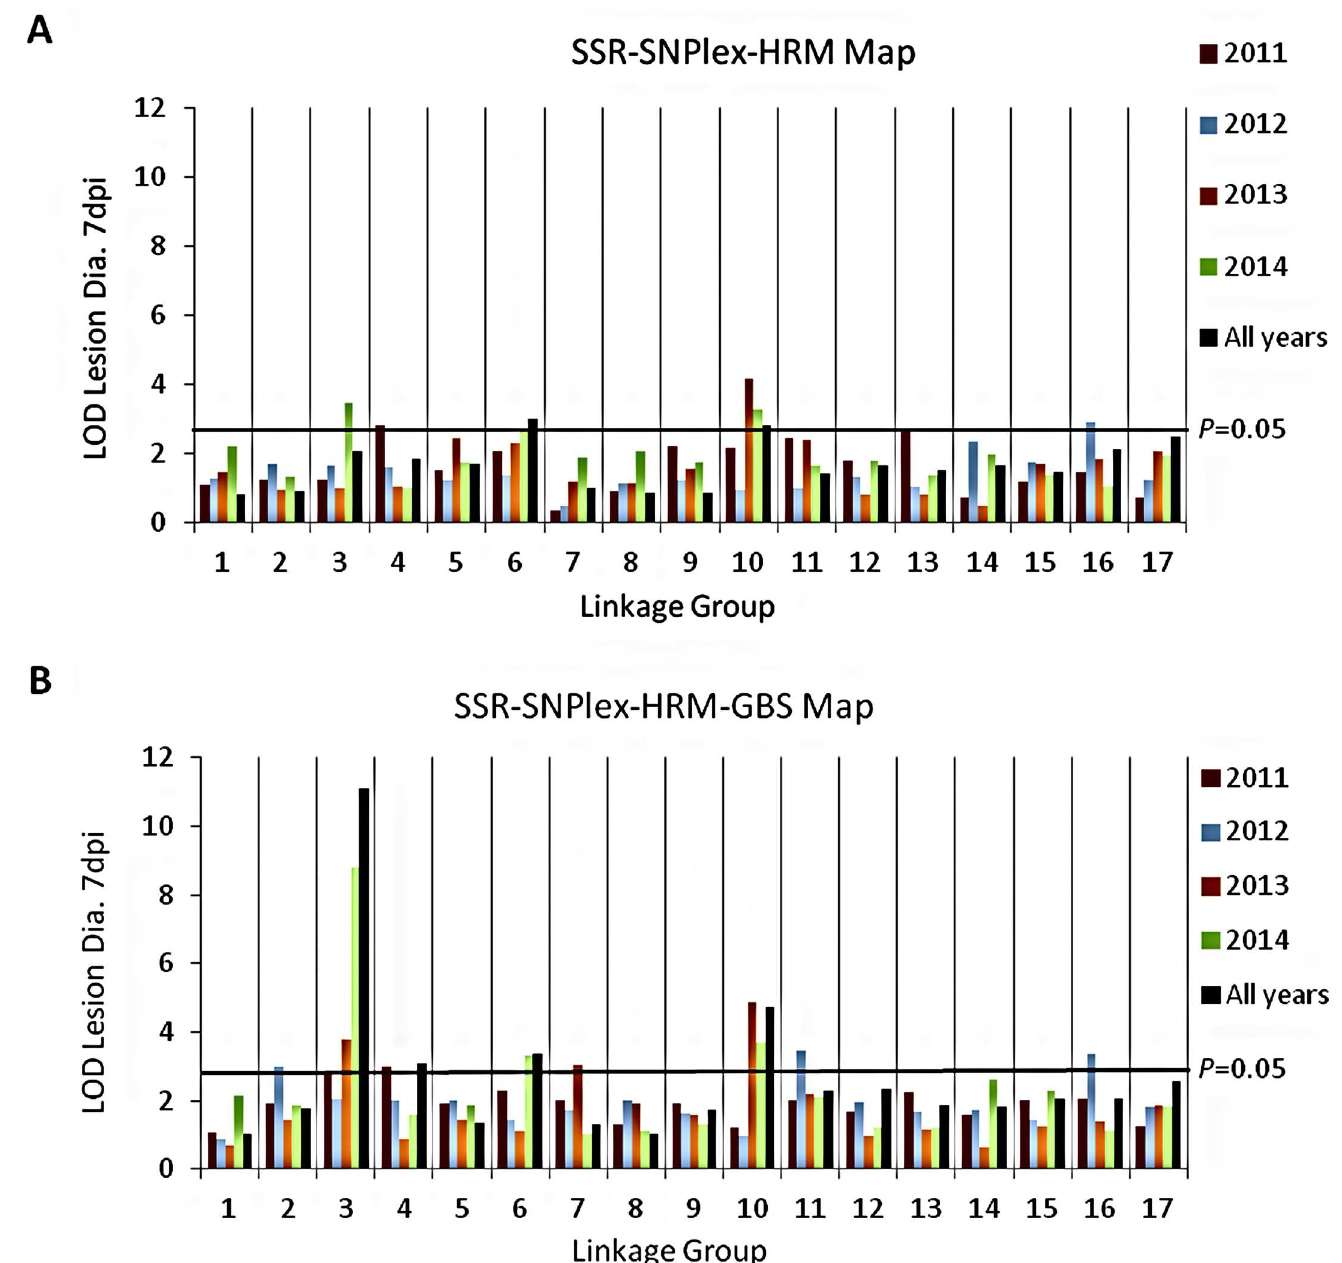
Fig 4. The highest interval mapping LOD score observed on an individual genetic linkage group for the association between a DNA marker interval and the LSmean of blue mold lesion diameter 7 dpi determined for each year and data combined for all four years(All years). Interval mappingLOD scores were determinedusing MapQTL6 (Kyazma B.V., Wageningen,the Netherlands) and genetic linkagemaps for the GMAL4593 mappingpopulationcontaining A : SSR, SNPlex, and HRM markers and B : SSR, SNPlex, HRM, and GBS markers. The P = 0.05 thresholdwas estimated basedupon previouslarge-scalesimulations